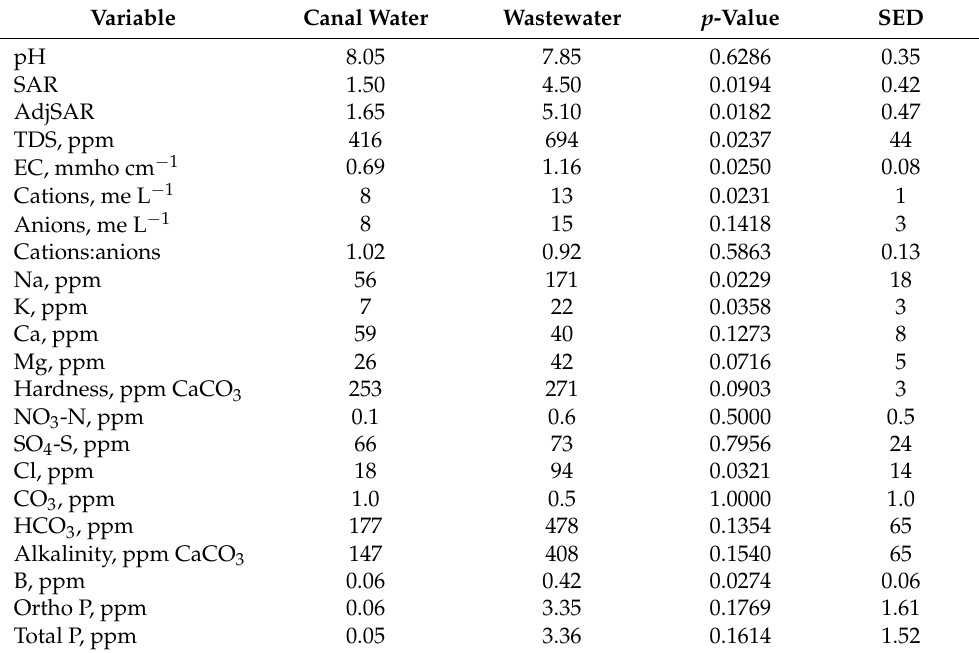
Table 2. Means of irrigation water quality analysis and results of statistical analyses of canal water and Class 1B treated municipal wastewater used to irrigate alfalfa during establishment at Tucumcari, NM, USA. Values are the least squares means of samples (one from each water source) collected before and after the study period